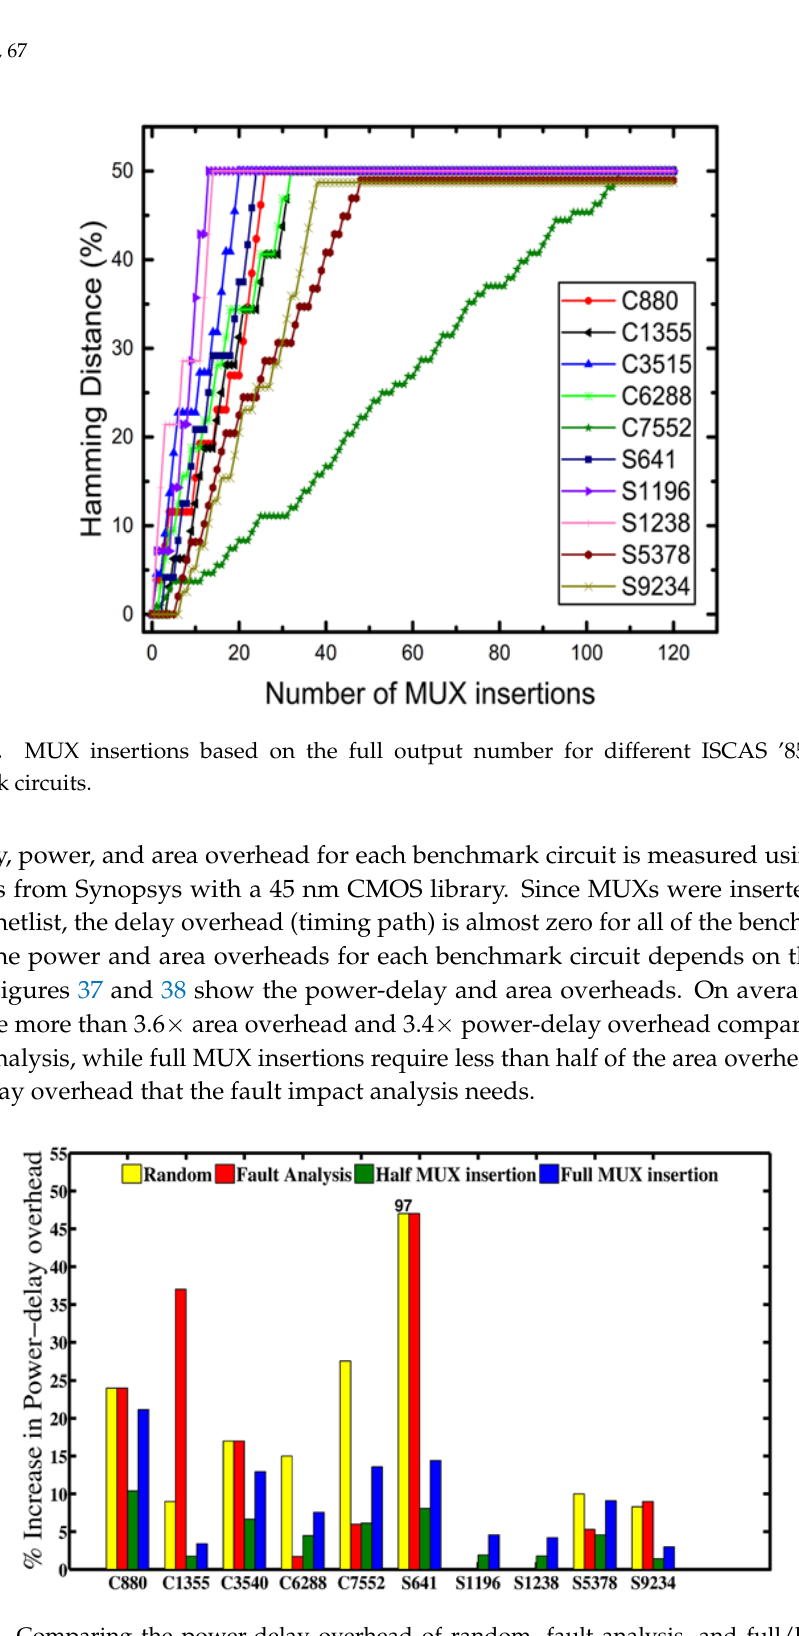
Figure 38. Comparing the area overhead of random, fault analysis, and full/half MUX insertions for logic encryption. Several kinds of attacks have been proposed to reveal the vulnerabilities of various logic locking methods to dispute the correct key of the locked circuit [101]. However, the most powerful one is a Boolean satisfiability (SAT) ‐ based attack [102]. By employing few discriminating input patterns, an SAT ‐ attack successfully exposes the secret key of all logic locking methodologies. These discriminating input patterns are supplied to the encrypted circuit and their corresponding outputs are compared with the correct output patterns, where they are obtained from an activated IC in the open market. An SAT algorithm is used to determine these input–output golden pairs. As a result, an SAT attack uses only the affected input patterns and therefore decrypts a large ‐ scale circuit that has large key sizes within a few minutes. An SAT attack can be mitigated via incorporating a small logic circuit as a Tree of AND gates that works as a one ‐ function output. Yasin et al. [103] implemented a lightweight logic block, namely the Anti ‐ SAT technique, to protect the locked netlist from an SAT ‐ based attack. Part of the input key ‐ bits (KA) is used for encrypting and decrypting of the locked design, while the rest of the key ‐ bits